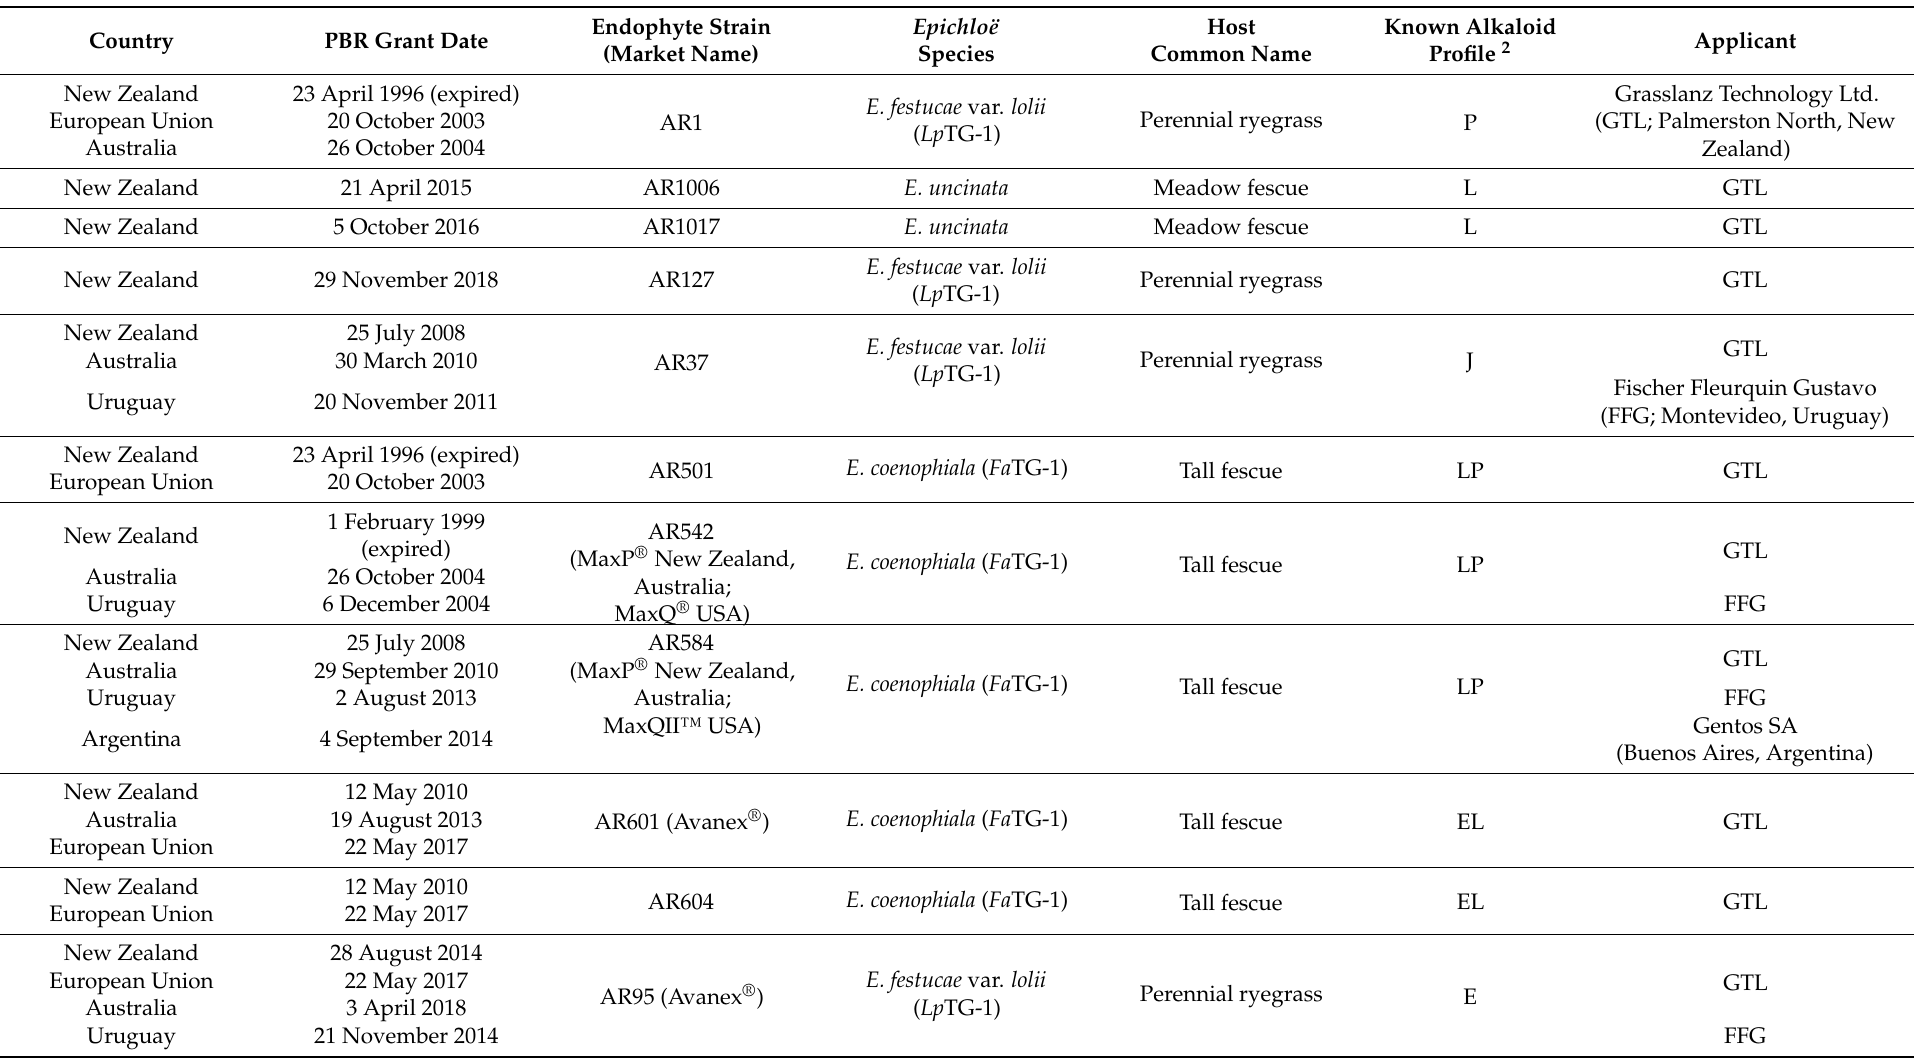
Table 1. Novel Epichloë endophyte strains for which Plant Breeders’ Rights (PBR) have been granted worldwide 1